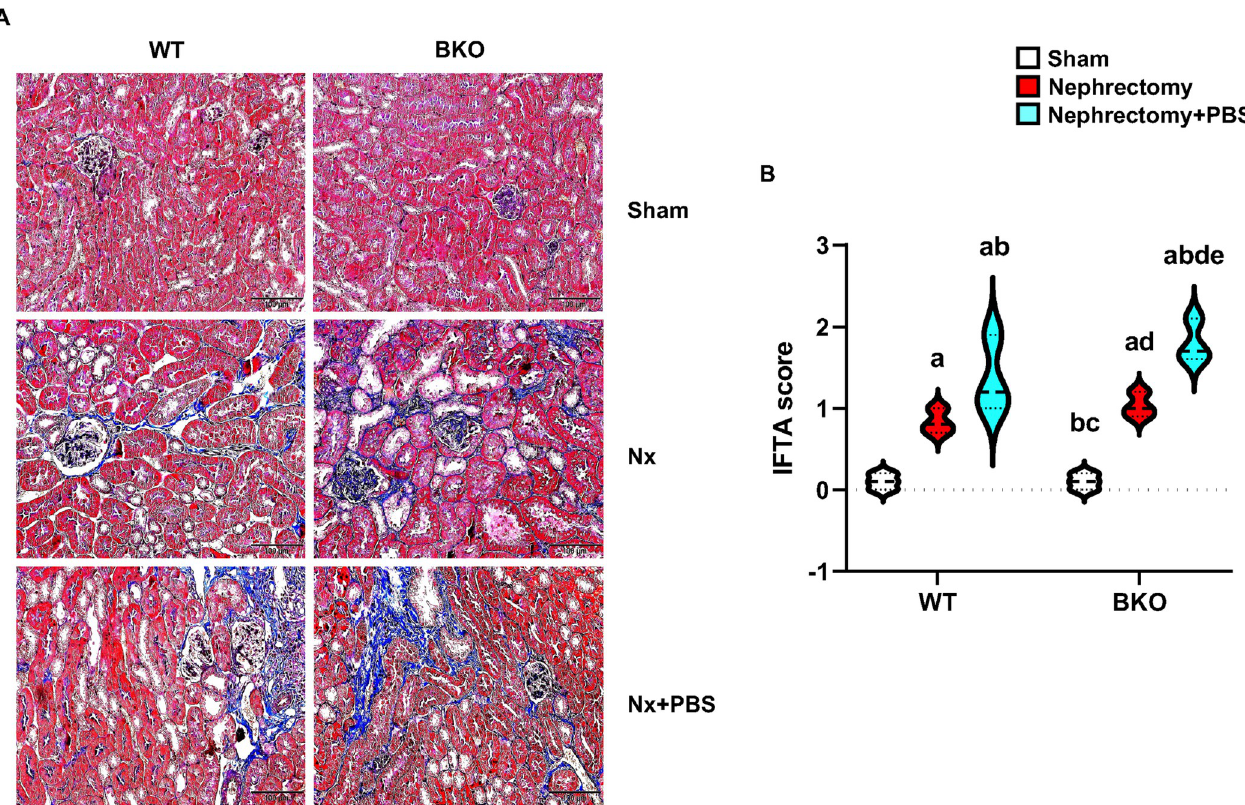
Fig 1. High phosphate enhances renal fibrosis in nephrectomized WT and BKO mice. (A) Kidneys stained with Masson’s Trichrome (n = 3 per group) from sham WT, nephrectomized WT, nephrectomized WT+PBS, sham BKO, nephrectomized BKO, and nephrectomized BKO+PBS mice. Blue color indicates fibrosis with an accumulation of collagen. (B) Violin plot showing IFTA scores in the kidneys. a p < 0.05 versus sham WT, b p < 0.05 versus nephrectomized WT, c p < 0.05 versus nephrectomized WT+PBS, d p < 0.05 versus sham BKO, and e p < 0.05 versus nephrectomized BKO. Scale bar: 100 μ m.